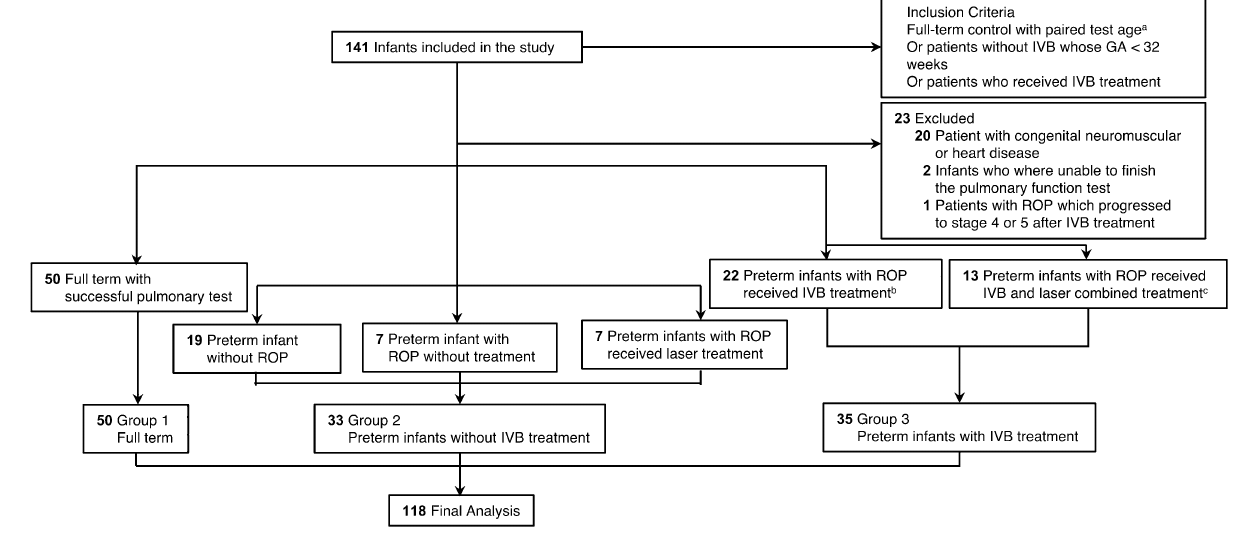
Figure 1. Flowchart showing the inclusion and exclusion of patients during the study period. Abbreviations: IVB, intravitreal injection of bevacizumab; ROP, retinopathy of prematurity. a Full-term children were matched to groups 2 and 3 by age at pulmonary function testing. b One patient received IVB in the right eye and laser treatment in the left eye. c One patient received IVB in the right eye and combined IVB and laser treatment in the left